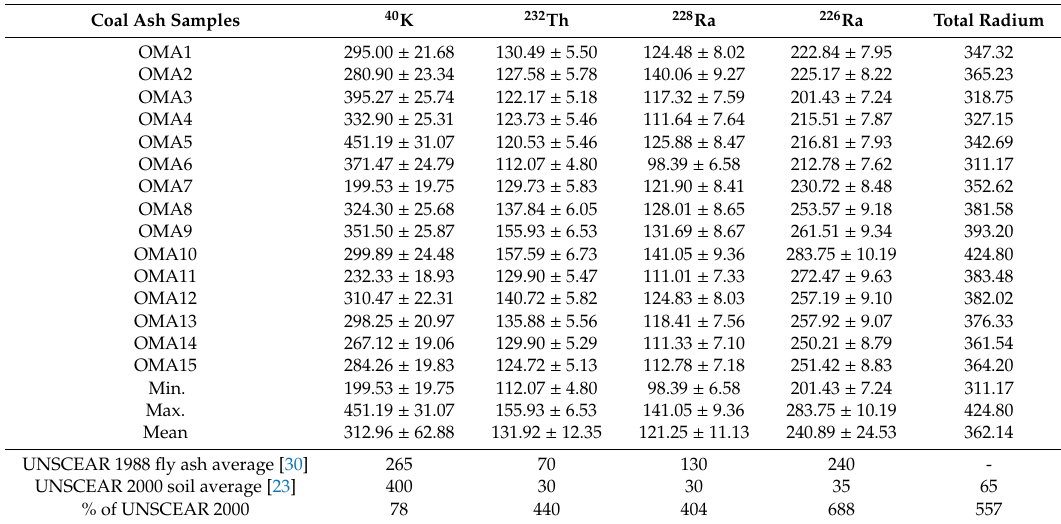
Table 4. Activity concentration of radionuclides in Omelewu simulant coal ash samples (Bqkg –1 ). Coal Ash